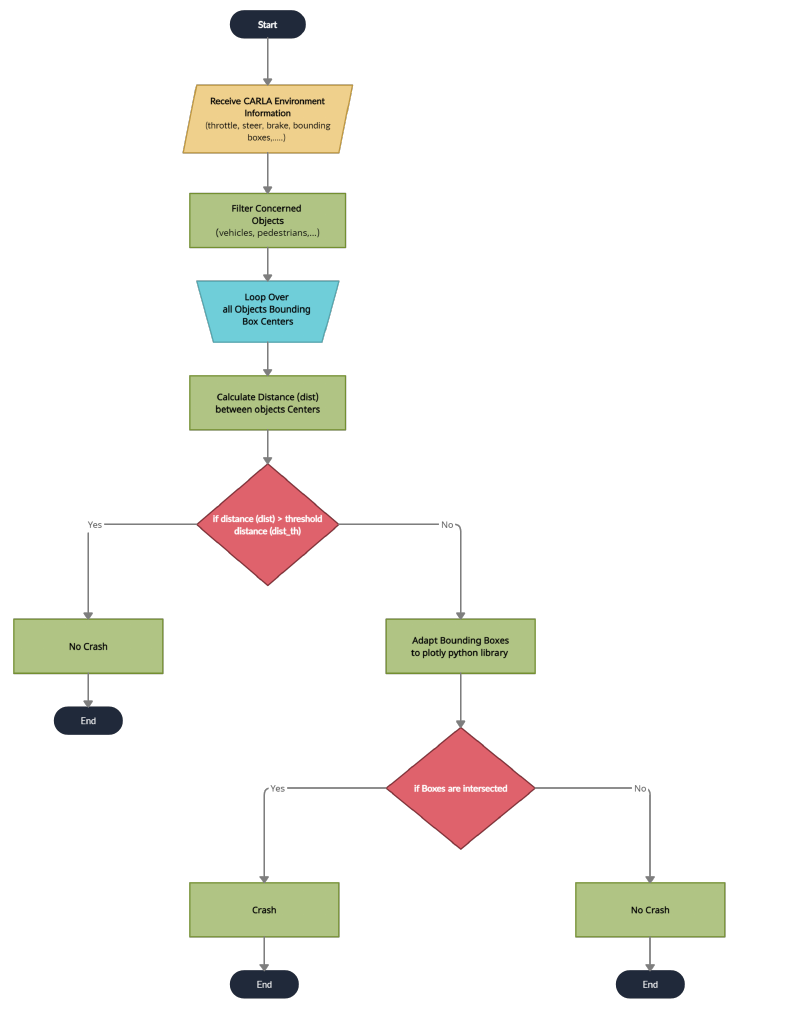
Figure 13. Crash labels processing